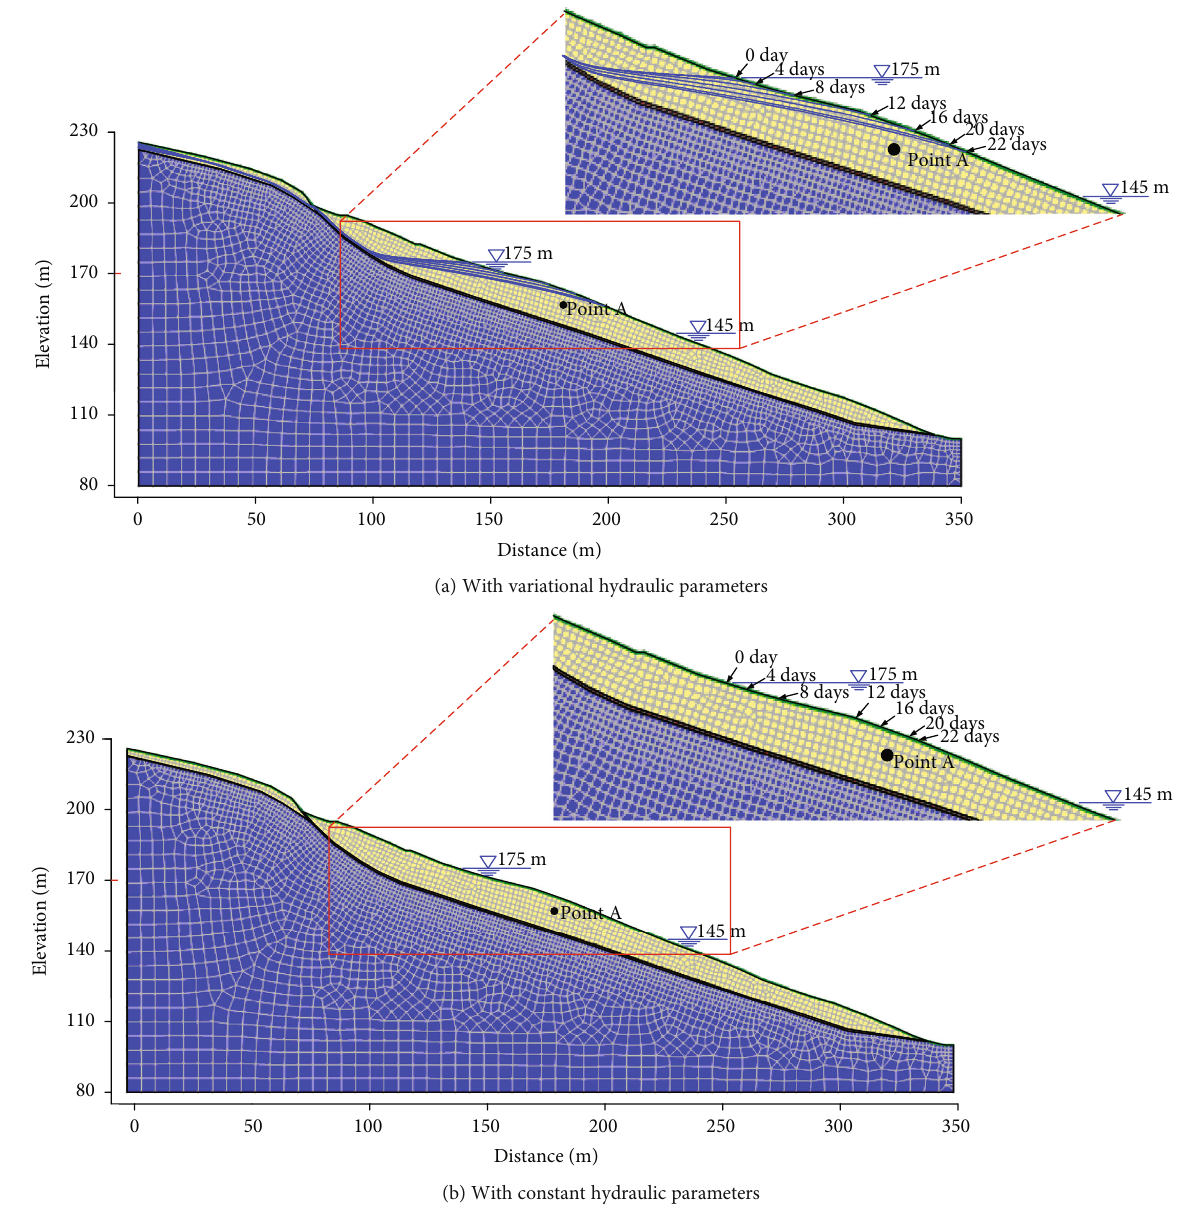
Figure 14: Variation of groundwater tables during reservoir water level